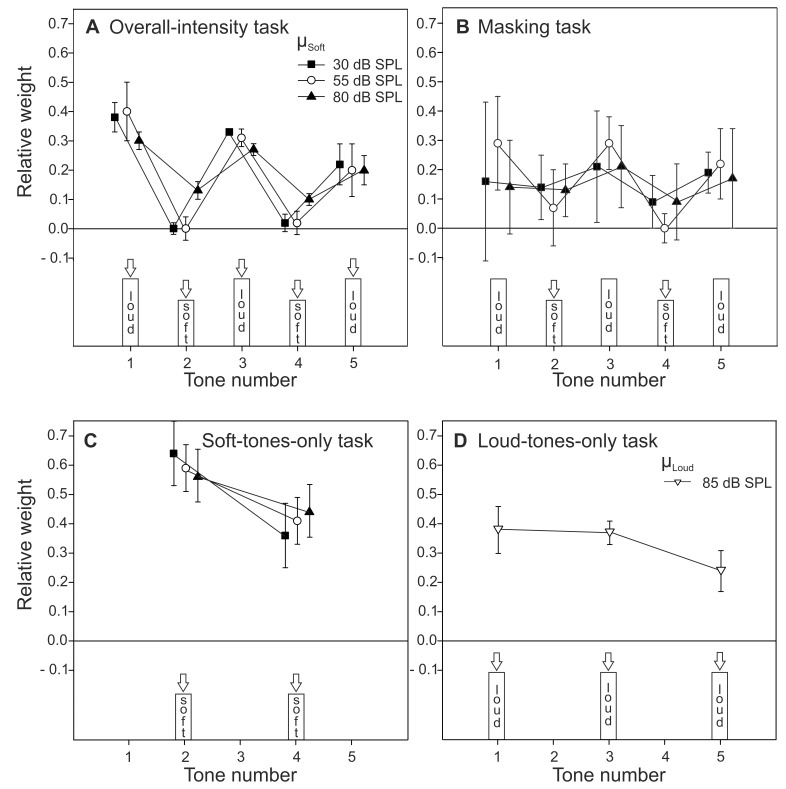
Mean normalized relative decision weights.Panel A: overall-intensity task. Panel B: masking task. Panel C: soft-tones-only task. Panel D: loud-tones-only task. Squares: µsoft = 30 dB SPL. Circles: µsoft = 55 dB SPL. Filled triangles: µsoft = 80 dB SPL. Open triangles: µloud = 85 dB SPL. Arrows mark target tones containing the increment. Error bars represent 95%-CIs.